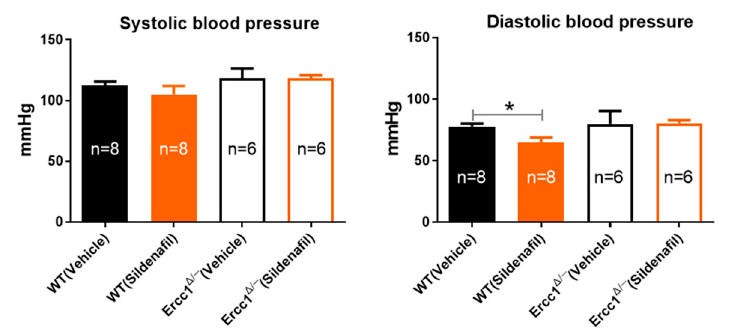
Figure 1. Systolic and diastolic blood pressure as measured with tail cuff in conscious Ercc1 Δ / − mice versus their WT littermates. The number of mice per group is shown in the bars. Statistical differences were analyzed by two-tailed t-test between vehicle- and sildenafil-treated mice (*, p < 0.05).